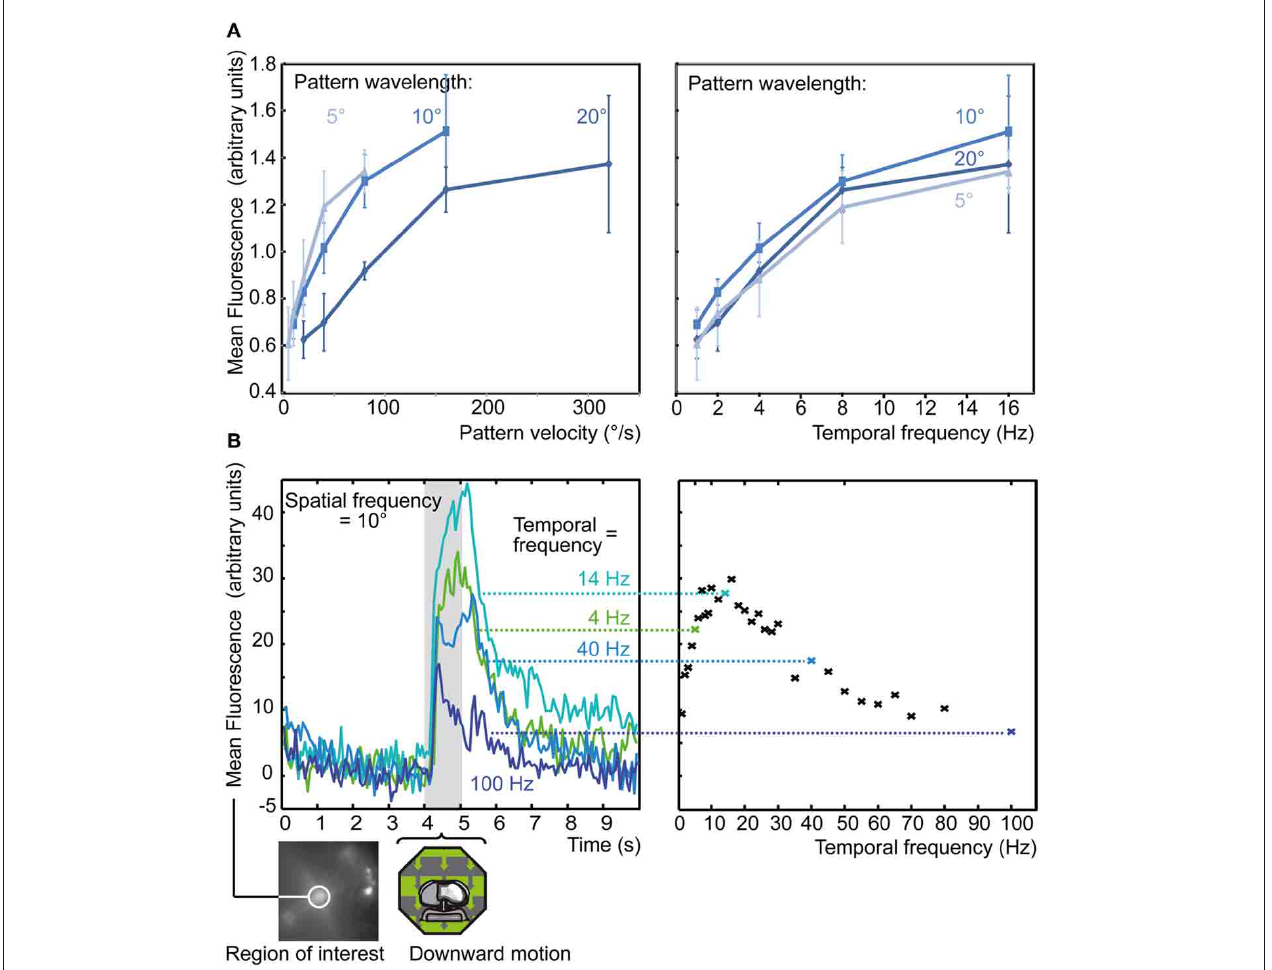
recordings, each from a circular ROI each centered on the injection site, ± SEM. Stimuli were presented on a 60Hz TFT screen. (B) Response of a single population staining (bottom left) to 1s of downward motion with varying temporal frequency. Each data point represents a single trial response, from a circular ROI centered on the injection site, with four corresponding example (cid:3) F traces shownto the left. Stimuliwere presented onahigh-speed